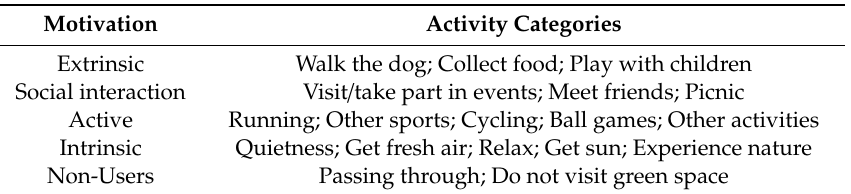
Table 1. Motivation and